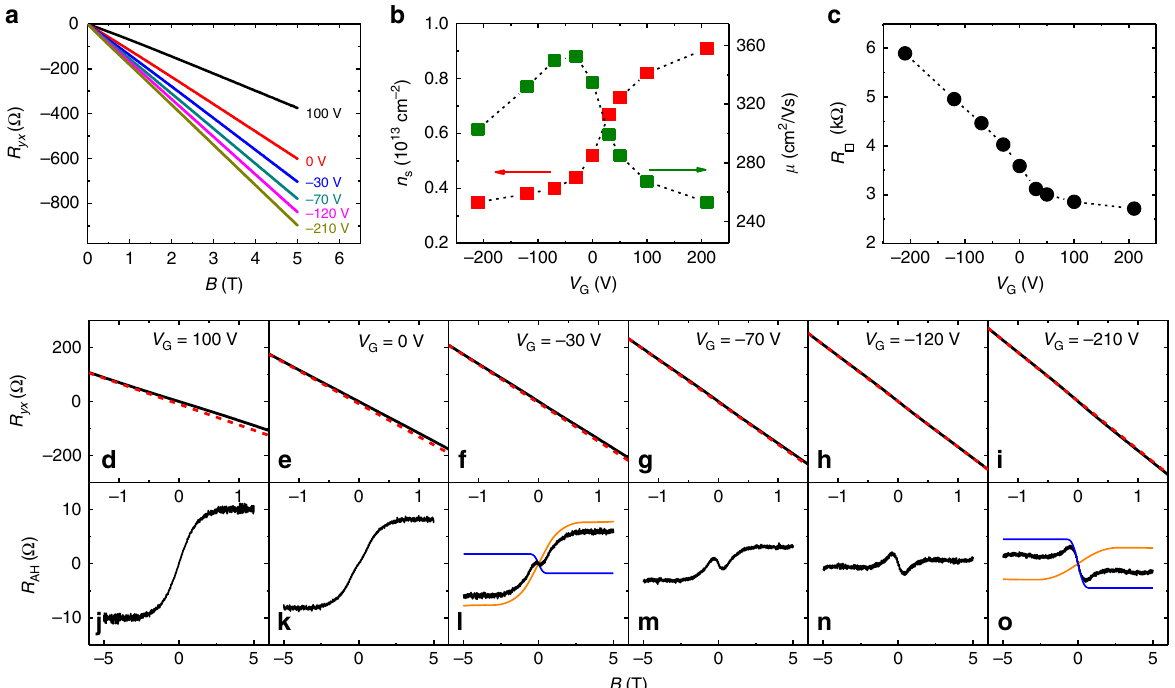
Fig. 3 Gate-voltage tuning of the anomalous Hall effect in a (Bi 1 − x Mn x ) 2 Se 3 thin fi lm ( x = 0.02). a Magnetic fi eld dependences of R yx at different gate voltages. b Sheet electron density n s (red square) and mobility μ (green square) plotted as a function of gate voltage V G . c Gate-voltage dependence of sheet resistivity R □ . d – i Magnetic fi eld dependences of R yx at gate voltages from V G = 100 to − 210 V. j – o Magnetic fi eld dependences of R AH for the same range of gate voltages as panels d – i . At V G = − 30 and − 210 V, the positive and negative AH components separated from the R AH curves (black) are shown in orange and blue lines, respectively. The Hall effect data were taken from Sample C at T = 1.6